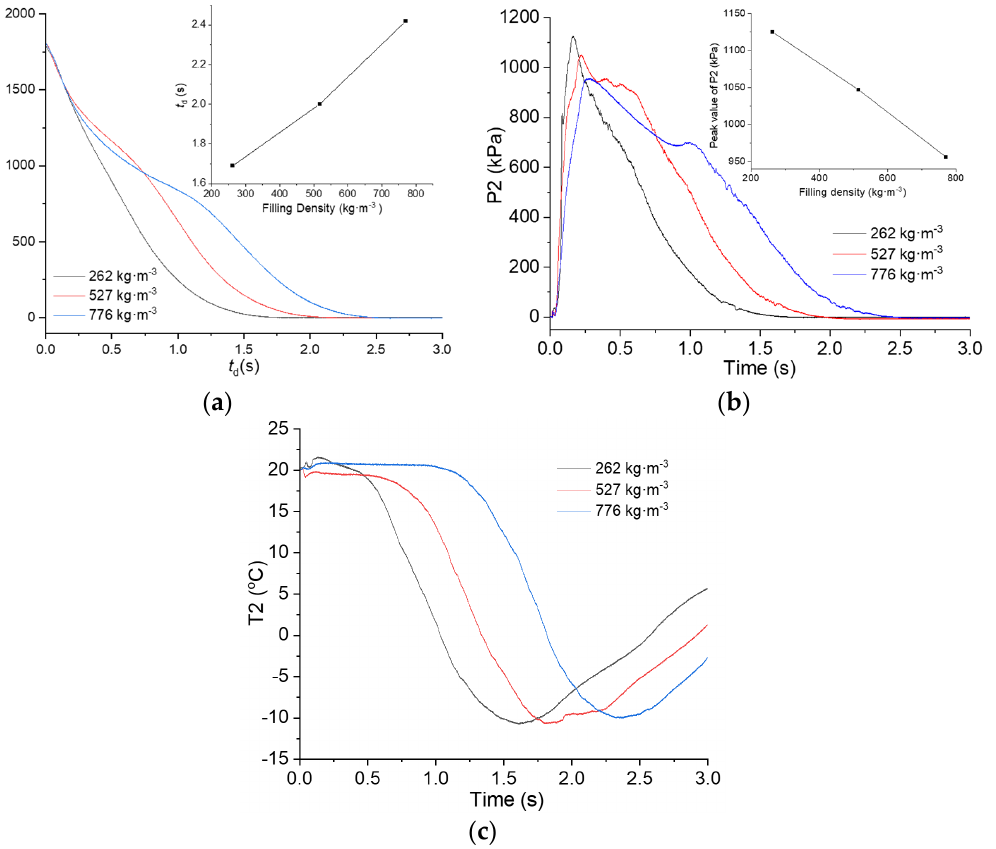
Figure 6. P–T profiles of the C 6 F 12 O tests at different filling pressures: ( a ) P v 0, the pattern inset showed the t d of the tests at different filling densities; ( b ) P2, the pattern inset showed the peak values of P2 at different filling densities; ( c )